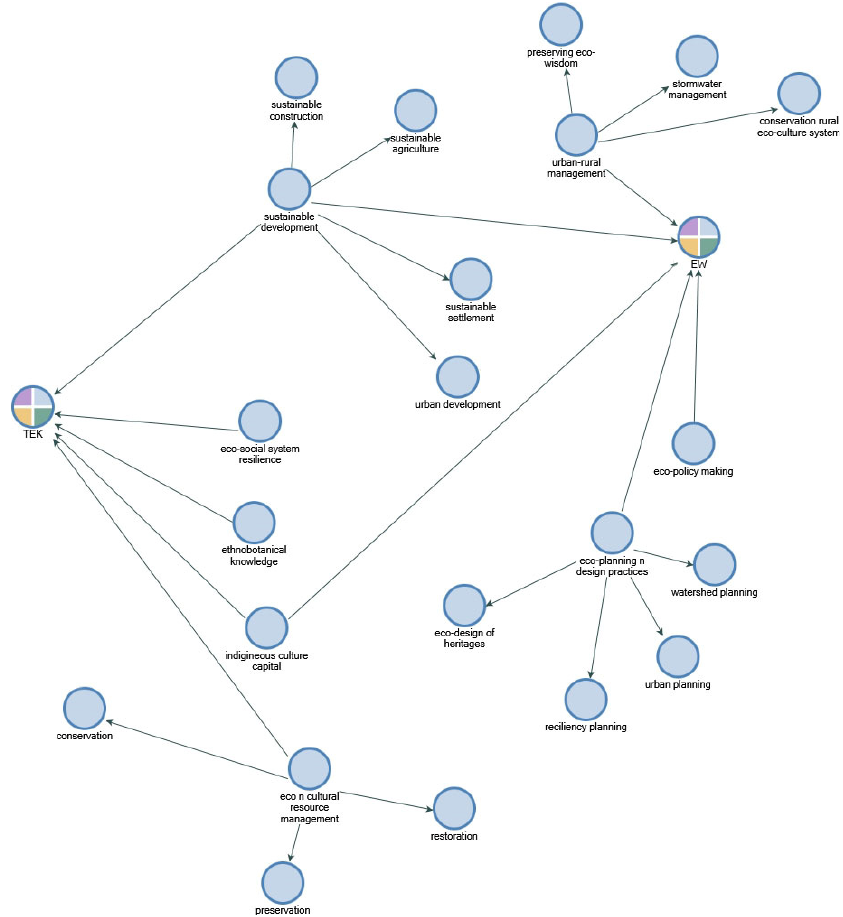
Figure 8. The connection diagram of the research scope between TEK and EW.